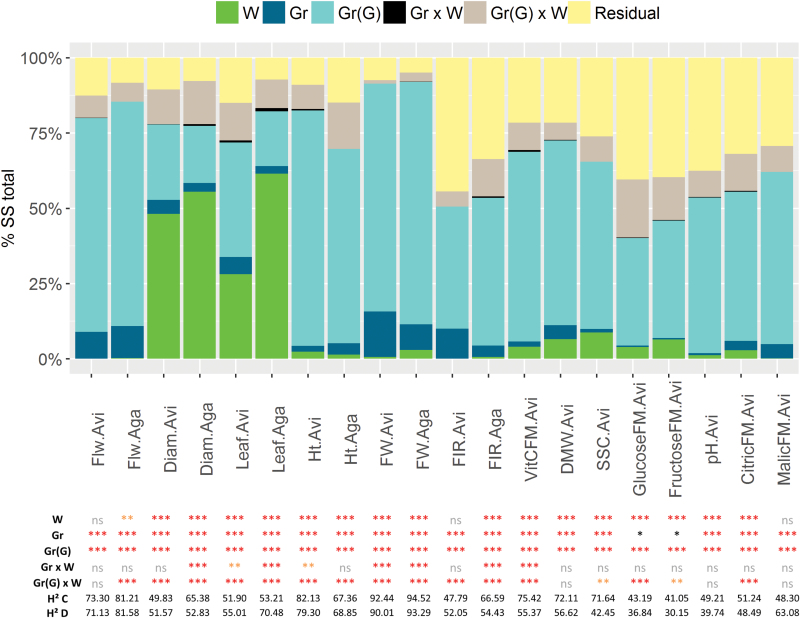
Dissection of the total phenotypic variation. For each phenotypic trait, the top figure displays the proportion of each effect in the total sum of squares: green for watering regime (W); dark blue for genetic group (Gr); light blue for genotype nested in genetic group [Gr(G)]; black for the interaction genetic group by watering regime (Gr×W); gray for the interaction genotype by watering regime [Gr(G)×W], and yellow for the residual. The table shows the significance of the P-value for the different effects: ***P<0.001, **P=0.001–0.01, *P=0.01–0.05, and ns >0.05. ‘H2 C’ and ‘H2 D’ indicate the broad-sense heritabilities in control and drought conditions, respectively.